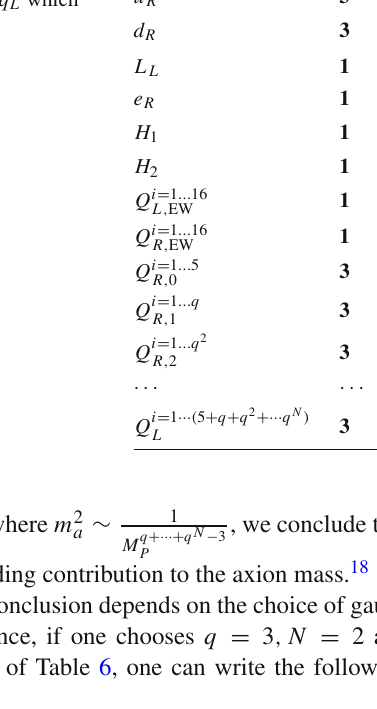
Table 7 Matter content for the quiver DFSZ model ( U ( 1 ) a charges are those imposed by (Appendix C.5), functions of q Q , q H , q e , q EW and q L which are